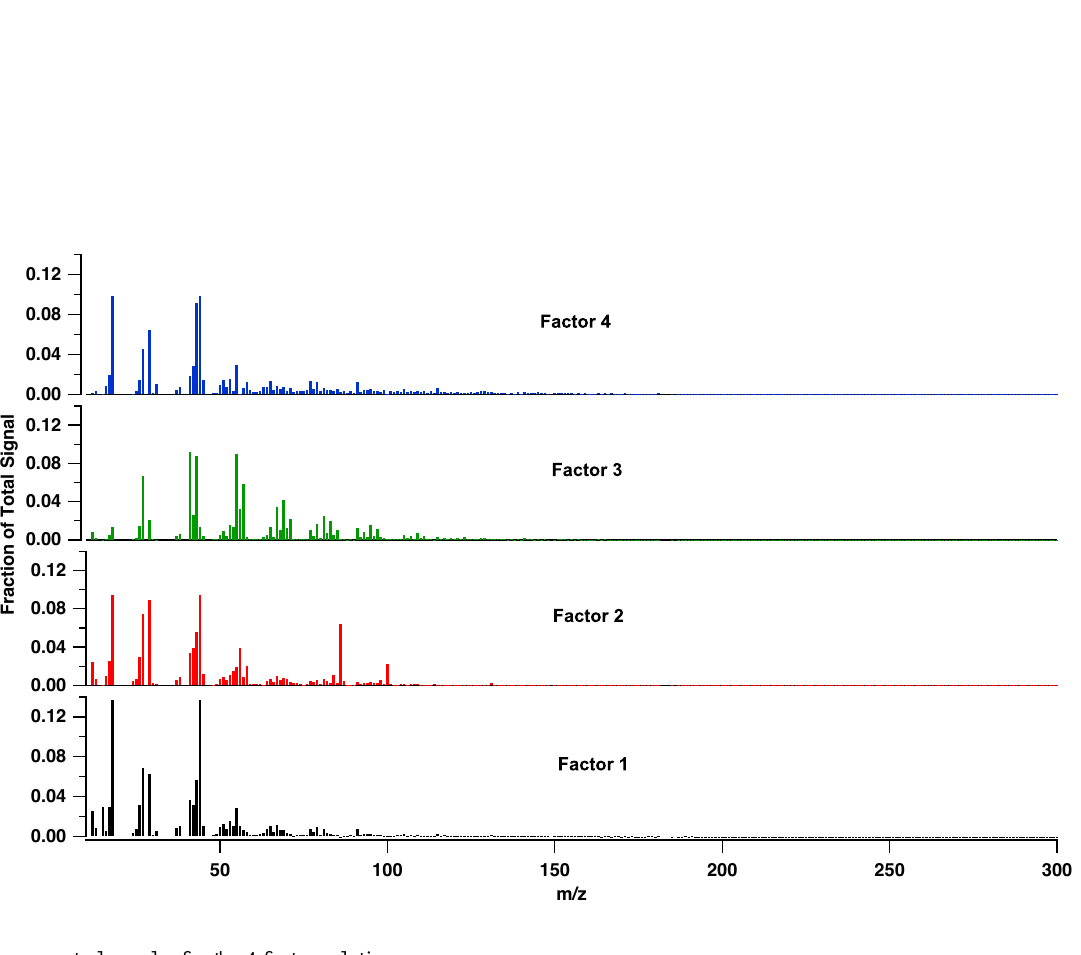
Fig. A5b. Mass spectral profiles for the 4 factor solution.